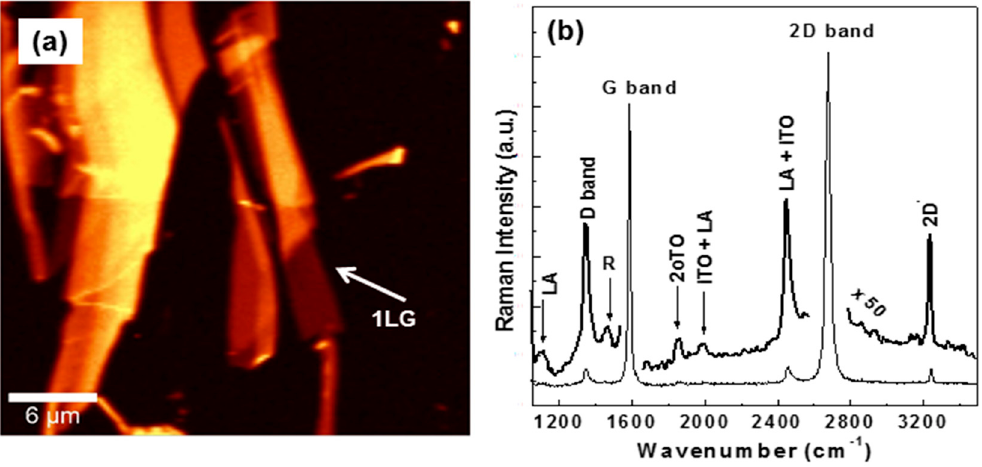
Figure 3. ( a ) Confocal Raman mapping of the G band depicting a microtube-like structure or of graphene whiskers; and ( b ) the associated Raman spectrum of image ( a ). New weak Raman vibrations, as labeled, are detected besides the characteristic graphene features.